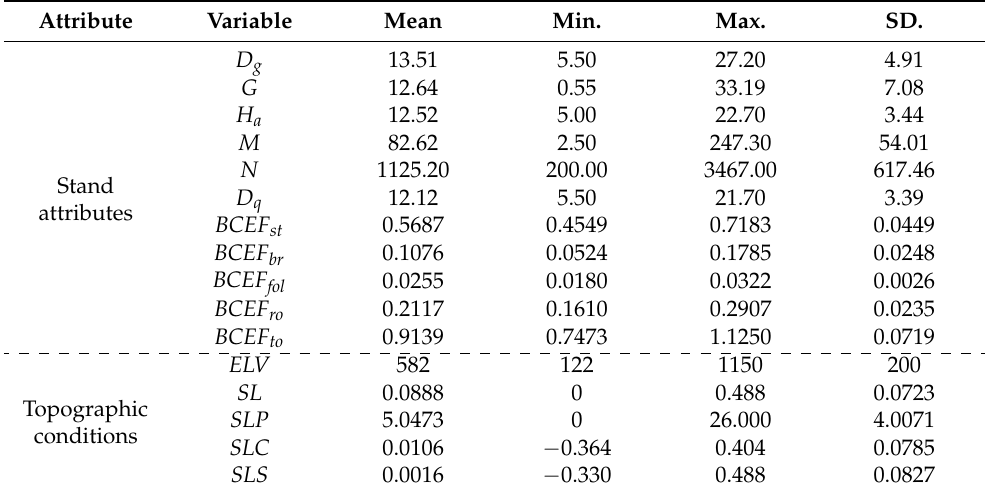
Table 2. Descriptive statistics of the stand variables and topographic conditions for birch.